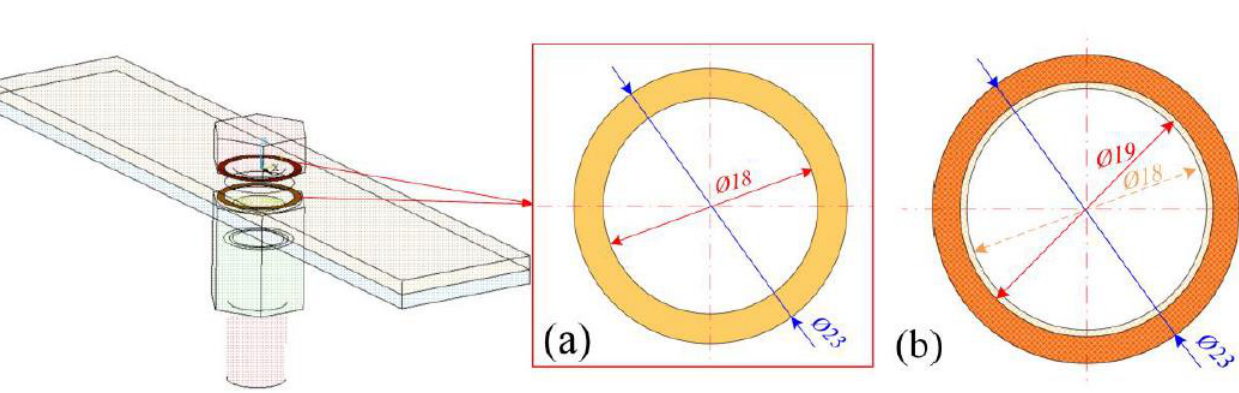
Figure 21. FRF amplitudes versus the ratio of ‘ Bolt tension/Excitation ’ , ( a ) two-beam joint, ( b ) one monolithic beam.